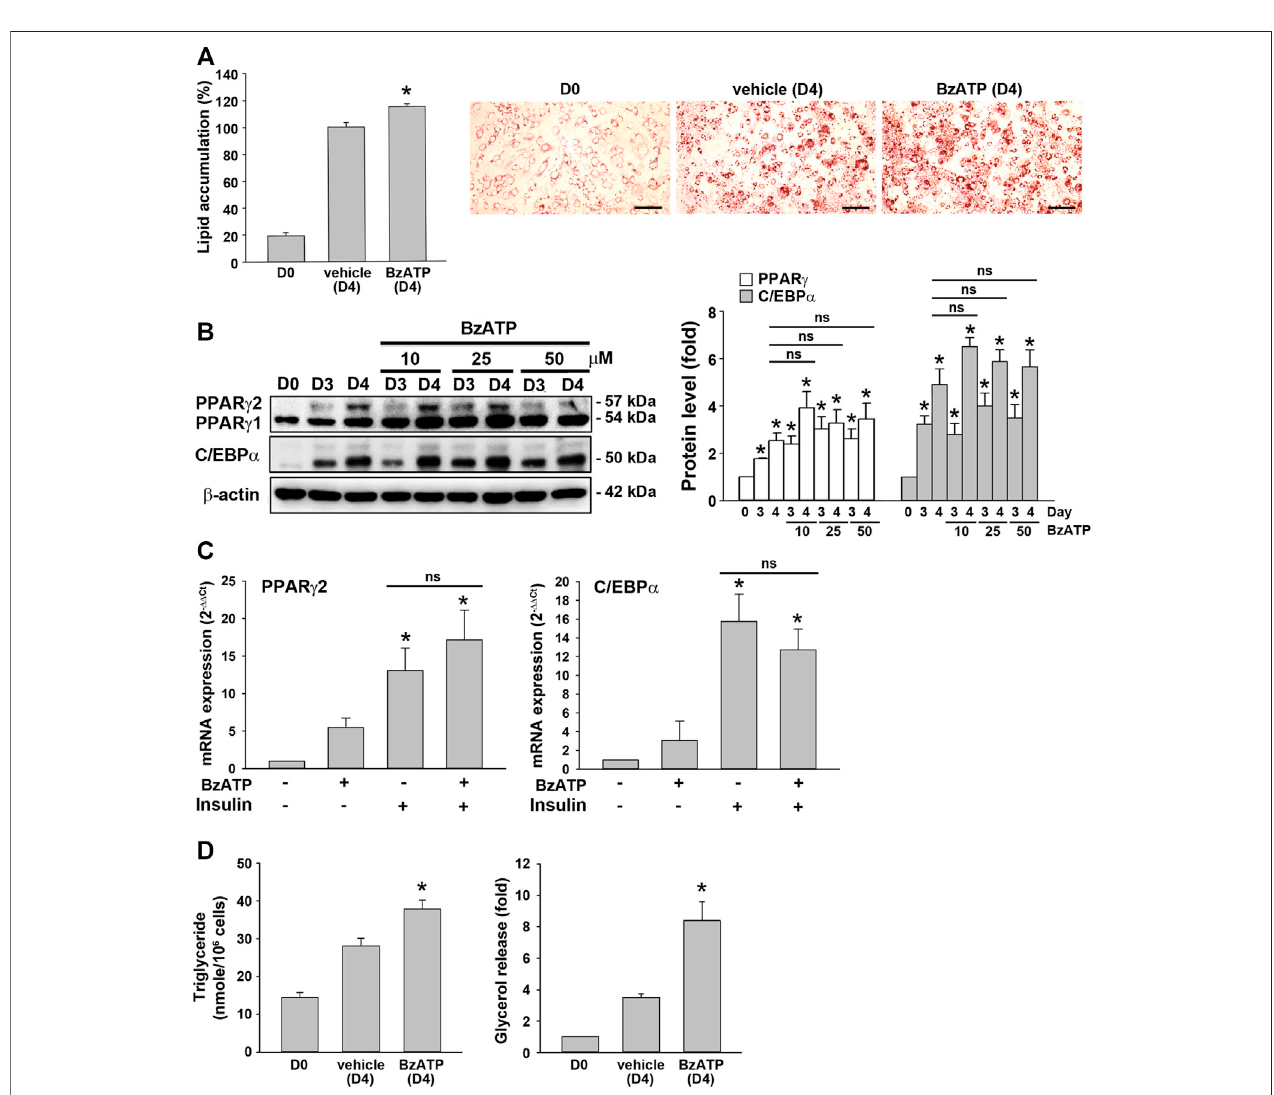
FIGURE3| P2X7activationatthesecondstageofadipocytedifferentiationissuf fi cienttoincreaselipidaccumulationwithoutaffectingadipogenicgenes. (A) Inthe two-stage differentiation model, cells were treated with vehicle or BzATP (50 μ M) at the end of D2. After 48 h (at the end of D4), cells were stained with Oil Red O to determine intracellular lipid accumulation. * p < 0.05 vs .vehicle-treated adipocytes (D4).Scale bar:100 μ m. (B) Cellsafter two-day fi rst-stage differentiation were treated with BzATP (10, 25, 50 μ M) for 24 h (determined at the end of D3) and 48 h (determined at the end of D4). The protein levels of PPAR γ and C/EBP α were determinedbywesternblot analysisand quanti fi ed bynormalizing to β -actin from threeindependent experiments. * p < 0.05 vs. vehicle-treated preadipocytesat D0.ns: non-signi fi cant. (C) Cells after two-day fi rst-stage differentiation were treated with BzATP (50 μ M) for 24 h in the presence or absence of insulin (1 μ g/ml). The mRNA levels of PPAR γ 2 and C/EBP α were determined by qPCR. * p < 0.05 vs . vehicle-treated adipocytes. ns: non-signi fi cant. (D) The cell lysate and cultured medium describedin (A) werecollectedtodetermineintracellulartriglycerideand extracellular glycerolcontent.* p < 0.05 vs .vehicle-treated adipocytes (D4). All quantitative data are presented as mean ± SEM from at least three independent